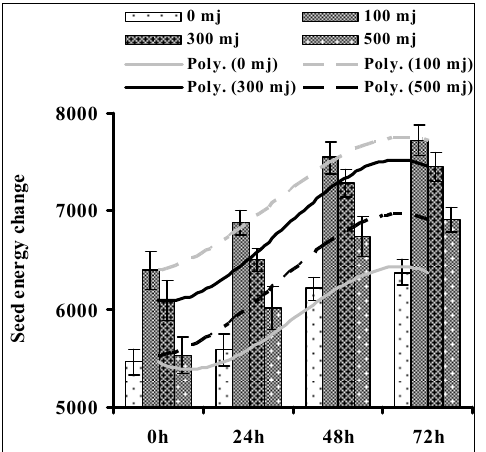
Figure 1. Seed energy during three days of germination of safflower seeds irradiated with He–Ne laser of different energies (mean ± SE; n = 4); (here poly. (0 mJ), poly. (100 mJ) . . . corresponds to polynomial regression to find out the trend).